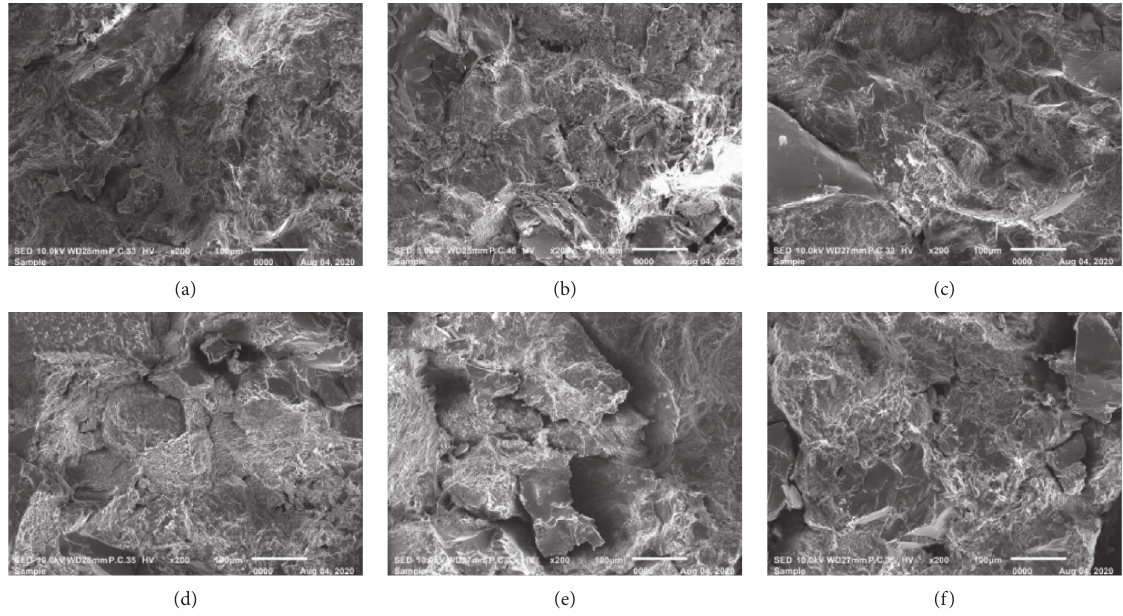
Figure 7: SEM images of sandstone with different water contents (magnifying 200 times). (a) ω � 0%. (b) ω � 0.57%. (c) ω � 1.06%.